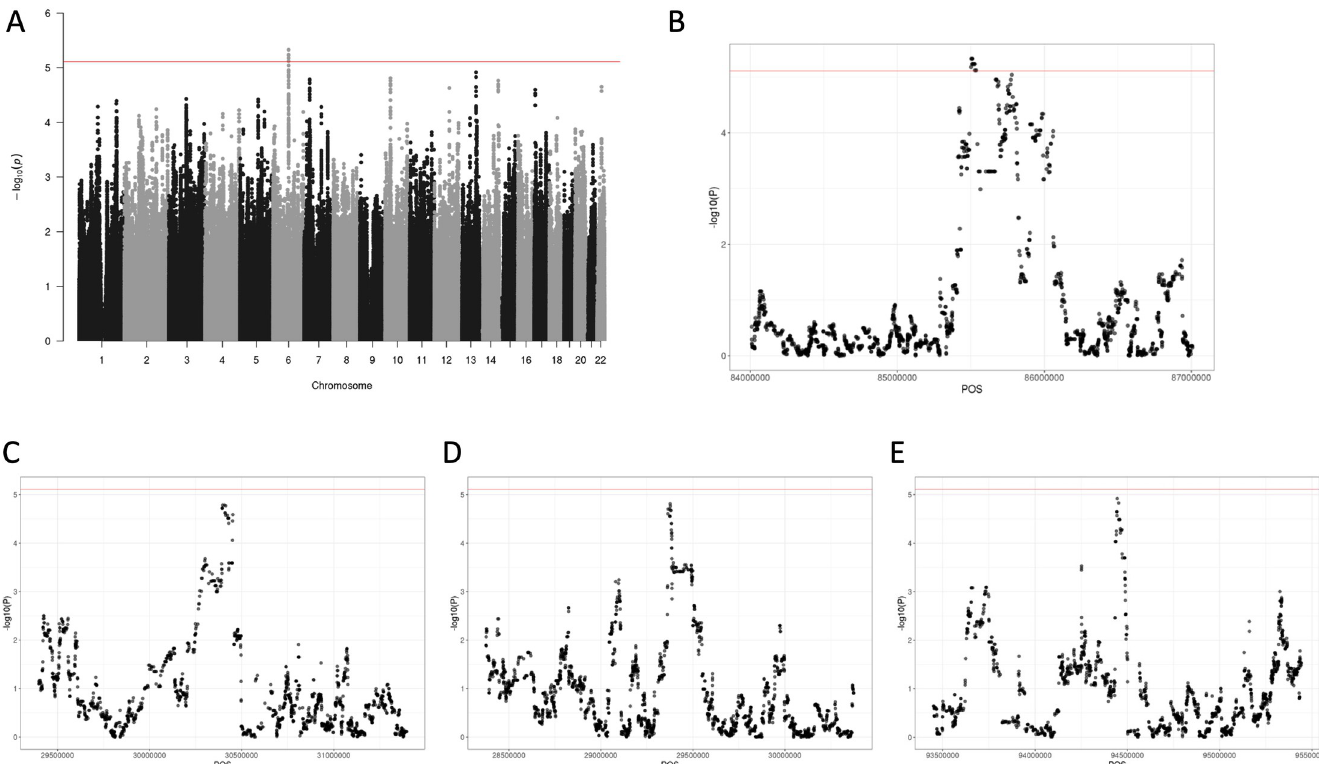
Fig 4. Association plots local European ancestry copies and risk of pilocytic astrocytoma in Latino subjects: 4A. An association plot of local European ancestry and pilocytic astrocytoma risk (admixture mapping) in Latino subjects, controlling for global European ancestry proportion, sex and first 10 genetic principal components. Significance level was determined by “STEAM” package to be 7.75x10 -06 , and estimated number of generations for this group is 12.2. 4B . Zoomed in peak of 4A for Chromosome 6 peak. 4C . Zoomed in peak of 4A for Chromosome 7 peak. 4D. Zoomed in peak of 4A for Chromosome 10 peak. 4E. Zoomed in peak of 4A for Chromosome 13